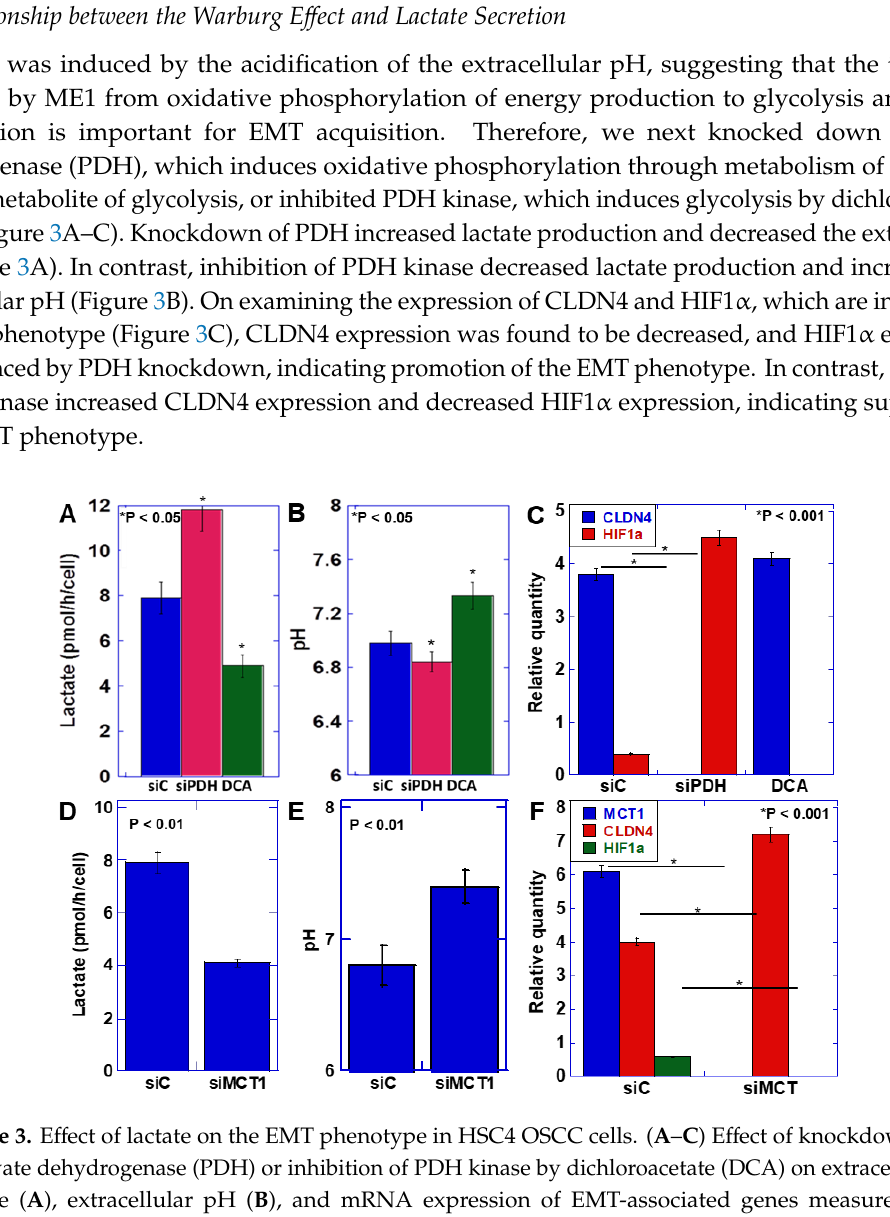
( B ) in HSC4 and KON cells. ( C , D ) E ff ect of the knockdown of lactate dehydrogenase A (LDHA) on extracellular lactate concentration ( C ) and pH ( D ) in HSC4 and KON cells. ( E ) E ff ect of medium pH on the EMT phenotype in HSC4 and KON cells. Expression was measured by quantitative PCR. Error bar, standard deviation tested by Student’s t -test in three independent trials. CDH, E-cadherin; CLDN, claudin; HIF, hypoxia-inducible factor; siRNA, small interference RNA; siME, siRNA for ME1; siC, control siRNA; siLDHA, siRNA for LDHA.